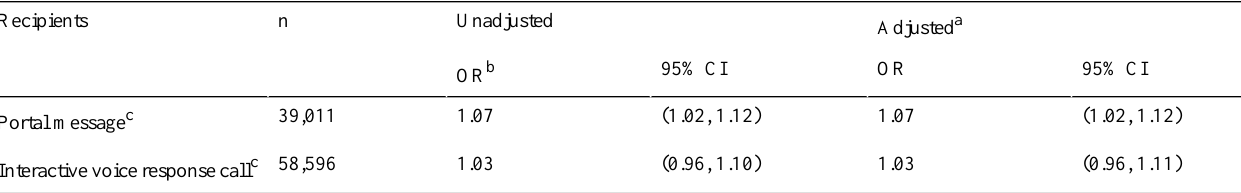
Table 2. Likelihood of receiving an early-season influenza vaccination.